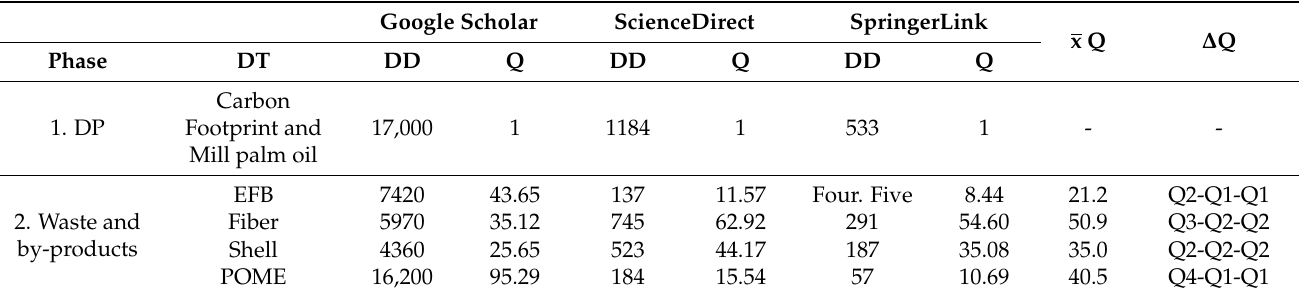
Table 3. Order of importance detected in relation to the carbon footprint in waste and by-products of the transformation of RFF worldwide in the